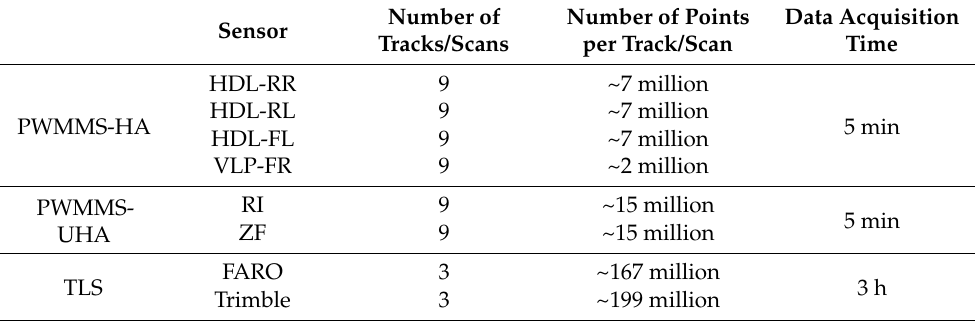
Table 1. Specifications of the acquired point clouds by PWMMS-HA, PWMMS-UHA, and Terrestrial laser scanners (TLSs) above and below the bridge in question. Number of Number of Points Data Acquisition Sensor Tracks/Scans per Track/Scan Time HDL-RR 9 ~7 million minHDL-RL 9 ~7 million PWMMS-HA 5